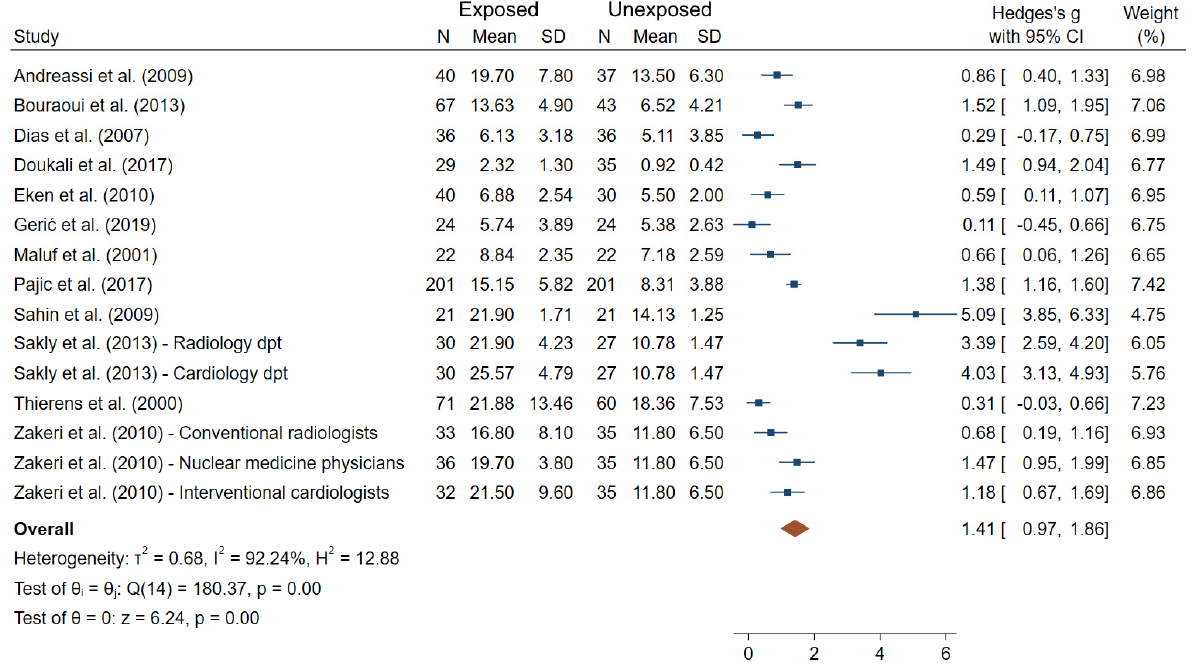
Figure 5. Forest plot of mean differences in MN frequencies between IR exposed and unexposed workers.